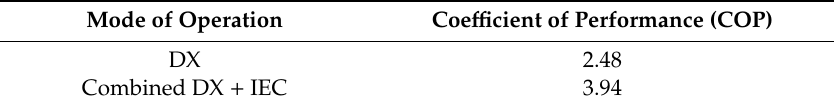
Table 4. COP calculated from experimental data for ambient temperatures greater than 40 ◦